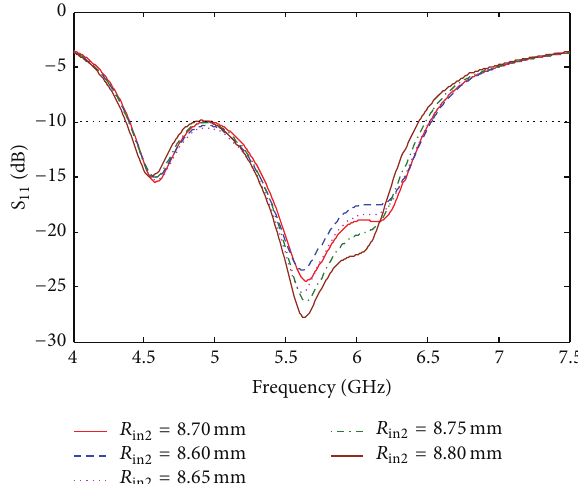
Figure 7: Frequency behavior of the magnitude of the reflection with 𝑊 = in 1 coefficients as a function of the inner diameter 𝑅 = 20.22 mm, 𝑅 = out 1 in 2 2.35 mm, 𝐿 = 21.79 mm, 𝑃 𝑥 = 3.85 mm, 𝑅 = 20.22 mm, and 𝑅 out 2